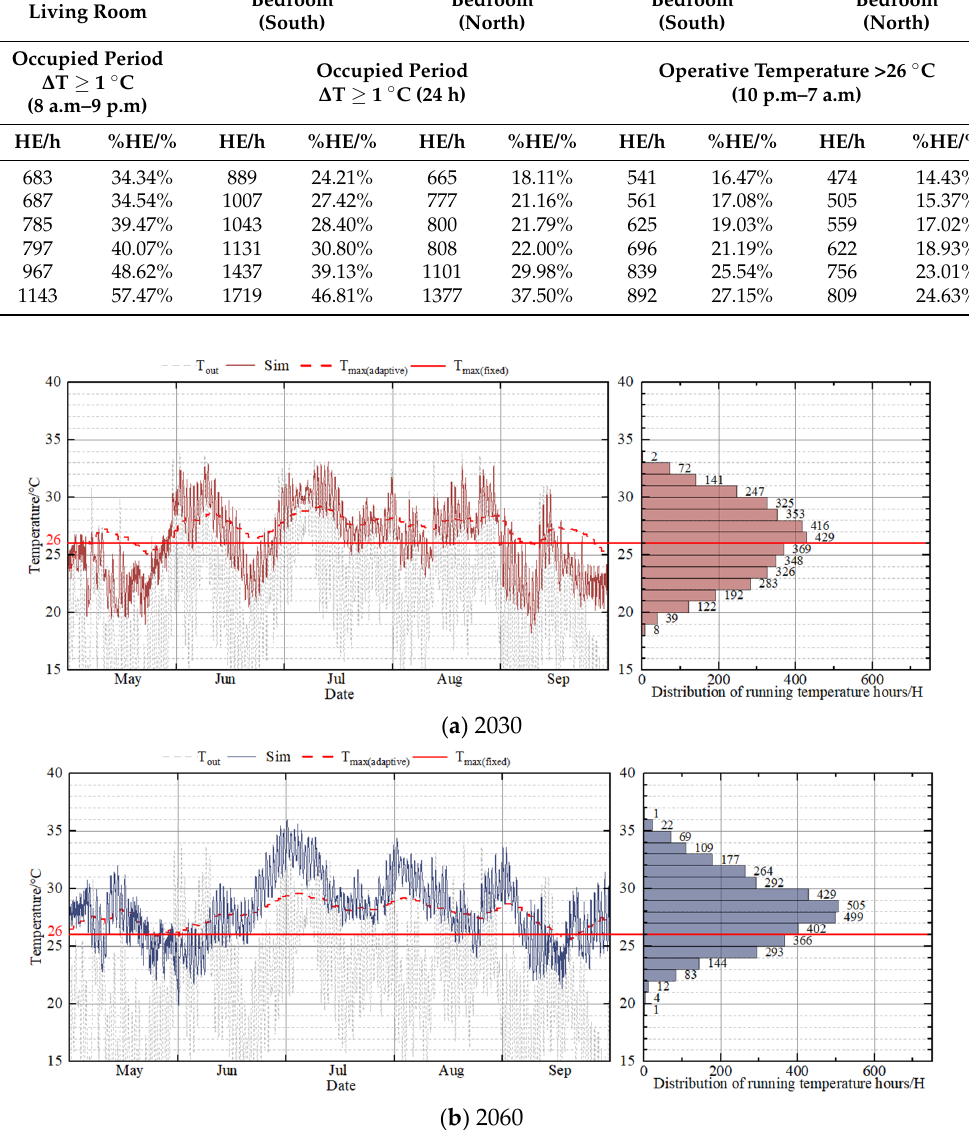
Figure 10. South-facing bedroom indoor temperature in temperature degree bands from May